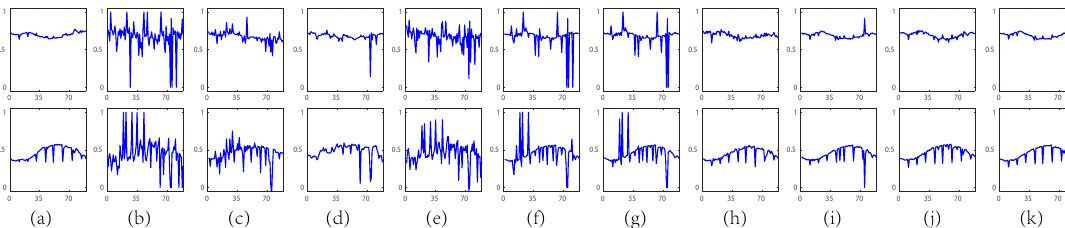
Figure 7. From top to bottom: Spectrum of pixels (78,61) and (137, 41) for the RemoteImage HSI dataset. From left to right: ( a ) Original HSI; ( b ) Noisy HSI; ( c ) SVD; ( d ) BM4D; ( e ) TDL; ( f ) WNNM; ( g ) WSNM; ( h ) LRMR; ( i ) LRTV; ( j ) NMoG; ( k )